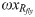
Model’s responses to a free fall (1).(A) Averaged simulated pitch orientation versus time in the 3 initiation time groups: 75 to 100ms (green line, top panel), 100 to 125ms (blue line, middle panel) and 125 to 150ms (red line, bottom panel). Gray lines are the experimental individual timelines. All the data were synchronized with the reference wingbeat triggering time: tWB = 0. (B) Averaged simulated optic flows, ωxRfly (solid line) and ωzRfly (dashed line), versus time in the 3 initiation time group: 75 to 100ms (green line, top panel), 100 to 125ms (blue line, middle panel) and 125 to 150ms (red line, bottom panel). Gray lines show experimental data of ωxRfly (solid line, dark gray) and ωzRfly (dashed line, light gray).